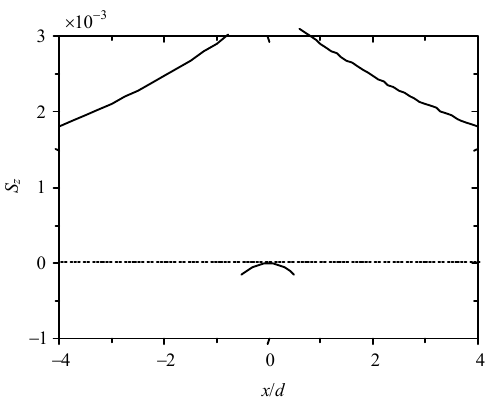
0.5 k d  for RCP even mode when 0